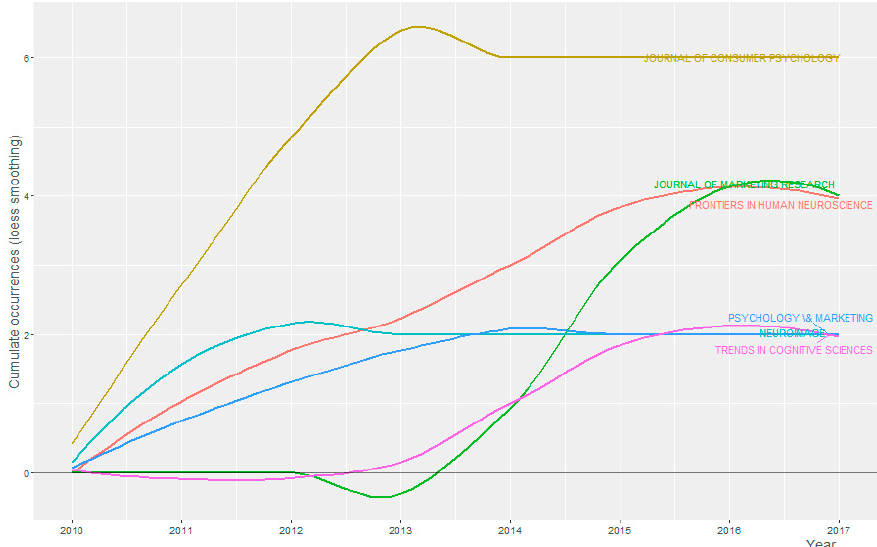
Figure 3. Source Growth. Cumulate Occurrences per Year and Number of Sources (5). Table 7. Source Dynamics.